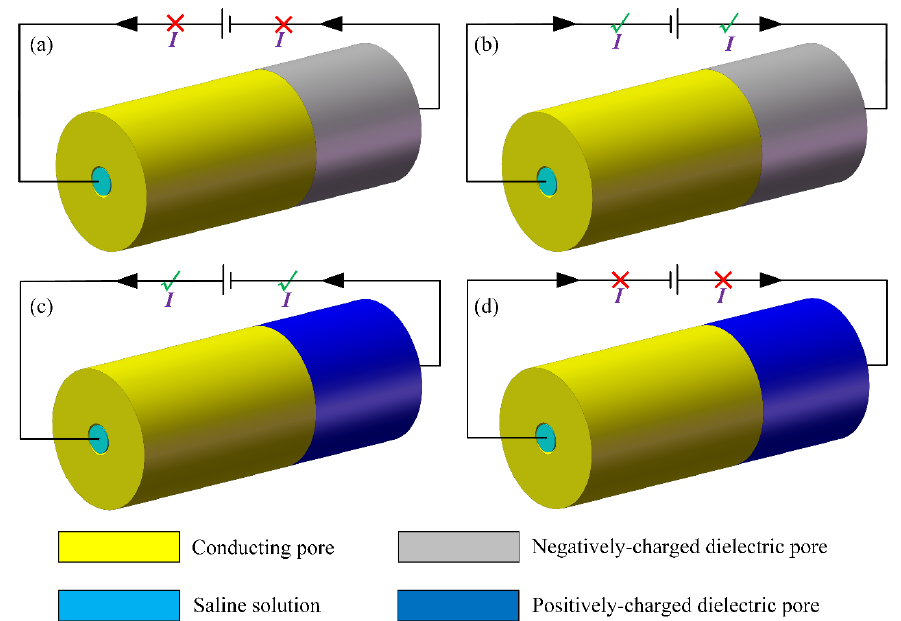
Figure 1. A 3D sketch of the metal-dielectric Janus nanopore, which serves as an active nanofluidic ion diode on the basis of ICEK-enabled internal concentration polarization, under an external DC voltage supply of reverse polarity. ( a , b ) The rectification trait of the asymmetric Janus nanopore with a cation-selective dielectric nanopore on the right side, ( a ) as the external DC electric field passes through the nanopore from the conducting side to the dielectric side, the ionic device works in the “off” state, and the forward electric current is forbidden, ( b ) with a reversal in the voltage polarity, the ion circuit platform transits to the “on” status, in which the backward current is well switched on. ( c , d ) Rectification characteristic of the nanoscale ion diode with an anion-selective dielectric nanopore on the right end, ( c ) for a positive DC bias, the nanoscale ion diode operates in the on state, in which the forward current flux is enhanced to great extent by the ion-enrichment zone formed at the midchannel, ( d ) for a negative DC bias, the functional ion platform transits to the off status, in which the backward electric current is switched off due to the ion-depletion zone induced at the critical junction between the enriched concentration of cations and anions.